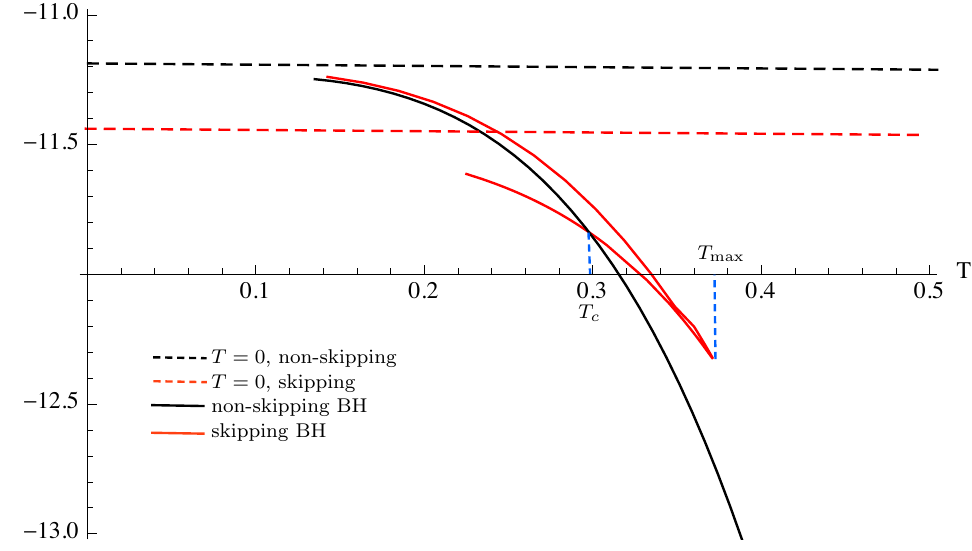
Figure 10 . The (cid:12)gure shows the free energy density as a function of temperature for the solutions connecting to UV 1 . The units were (cid:12)xed such that j = 1 (so that T = T ). The black curve corresponds to the non-skipping branch, and it extends from T = 0 to in(cid:12)nity. The red curves are the two skipping branches. The dashed horizontal lines represent the free energy of the zero- temperature skipping (red) and non-skipping (black) solutions. Of the two skipping black-hole solutions, the one with lower free energy connects to the true vacuum skipping (cid:13)ow as T ! 0 (The curves shown here do not reach all the way to zero temperature due to limitations in the numerics). Both skipping branches disappear at a maximal temperature, which is numerically found to be T max ’ 0 : 37 in units where j = 1. The phase transition occurs at the temperature T c ’ 0 : 3, where the skipping and non-skipping branches